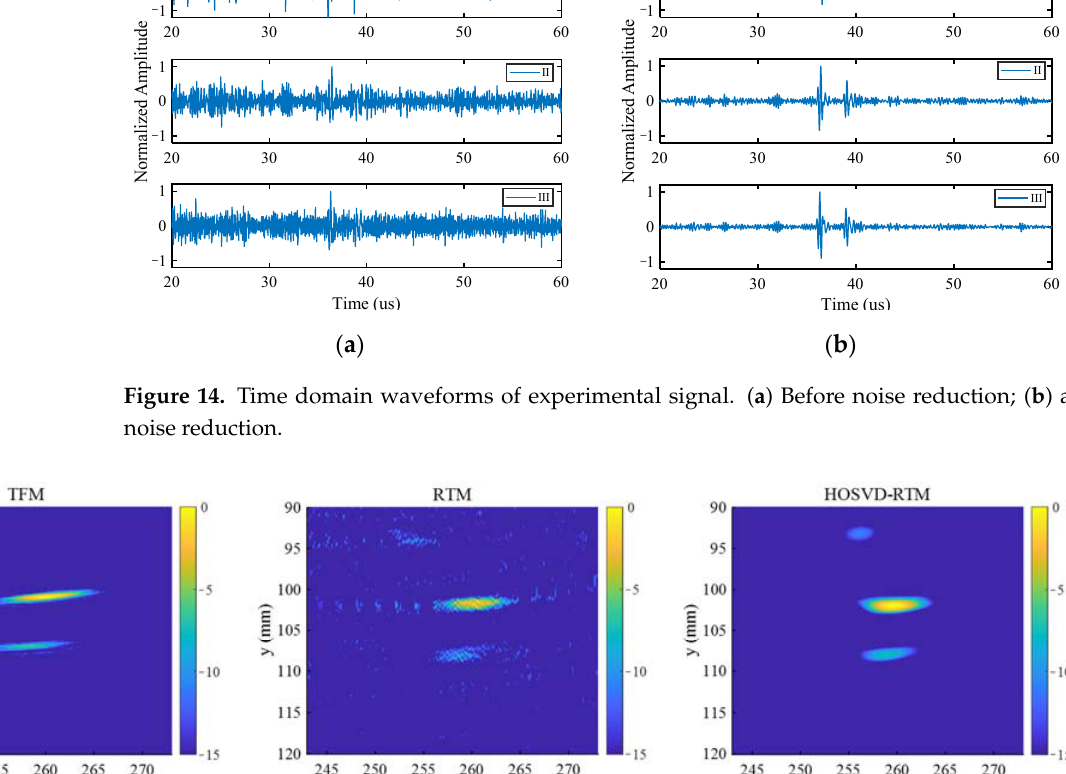
Figure 14. Time domain waveforms of experimental signal. ( a ) Before noise reduction; ( b ) after noise reduction.